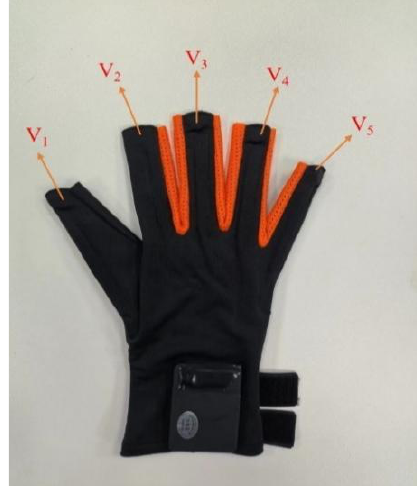
Figure 7. Schematic of the glove sensor.